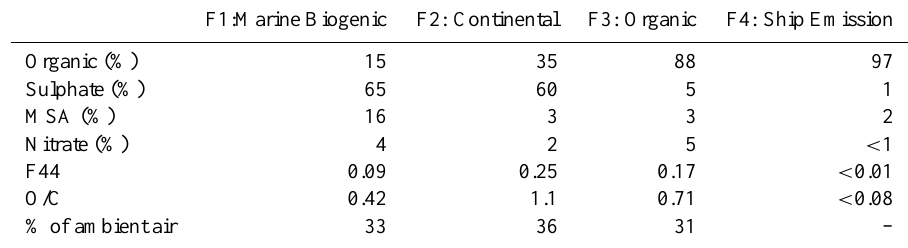
Table 3. Composition and % contribution of factors by mass from the four-factor solution for an fPeak of − 0 . 75. See Figs. S2 and S3 for uncertainties. O/C calculated using the equation from Aiken et al. (2008).